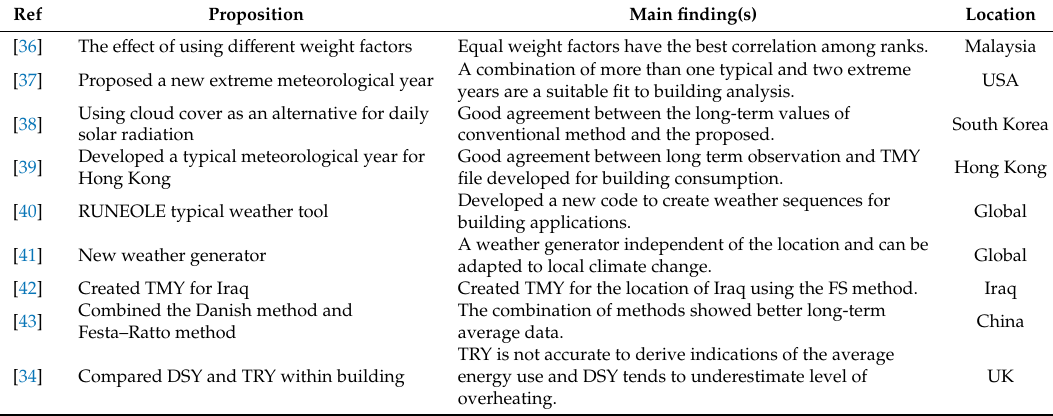
Table 1. Selected literature on creation and modification of Typical Years